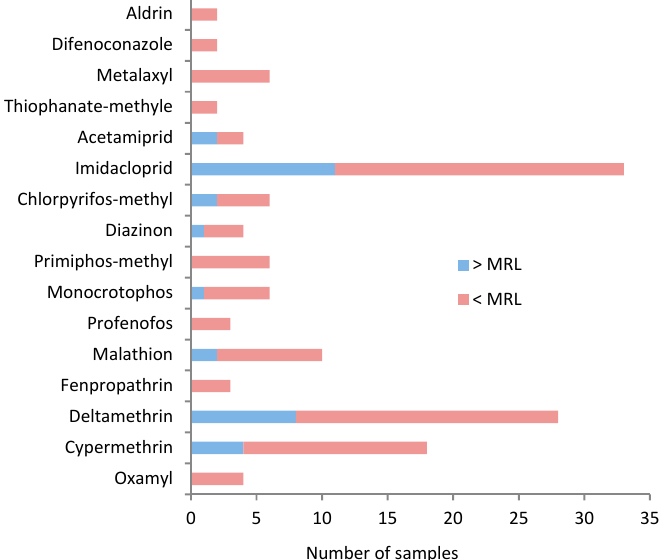
Figure 1. Type of pesticide detected and frequency of detection in fruit and vegetable samples. For each pesticide detected, the number of samples with residue below MRL or above MRL is indicated.